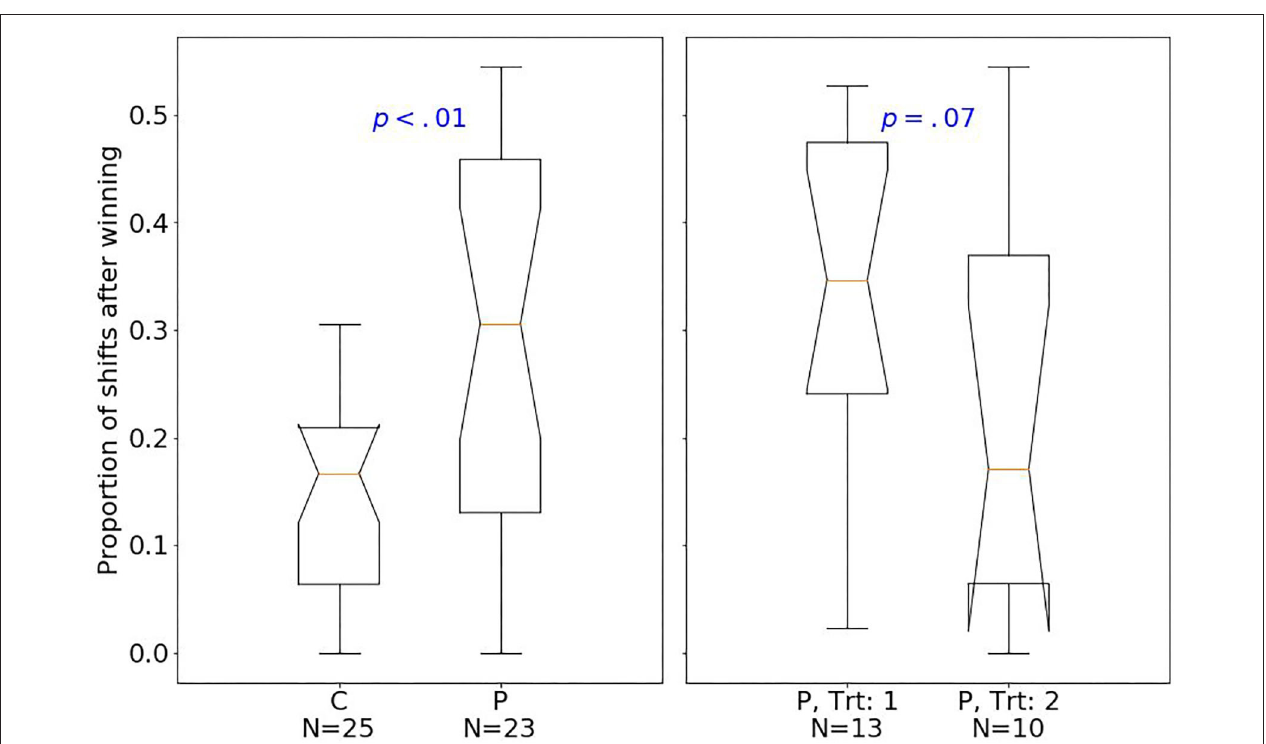
FIGURE 3 | Box plots of the PRL task. The horizontal line represents the median; the boxes extend to the first and third quartile, while whiskers extend to the max/min or the corresponding quartile + 1.5 IQR. C, healthy controls; P, patients with MUD; Trt_1, successful treatment outcome; Trt_2, unsuccessful treatment outcome. Box plots of proportion of shifts after